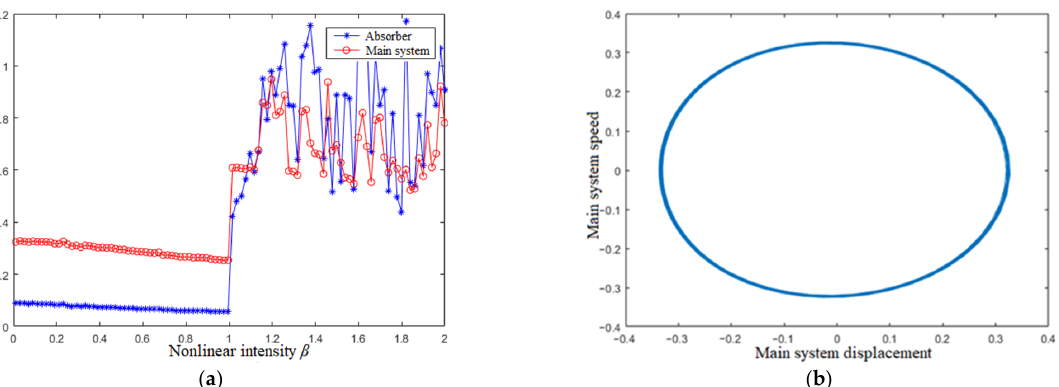
Figure 13. Response amplitude and phase diagram of two vibrators in the case of off-resonance ω = 1.6. ( a ) Response amplitude; ( b ) Phase diagram ( μ = 0.4).